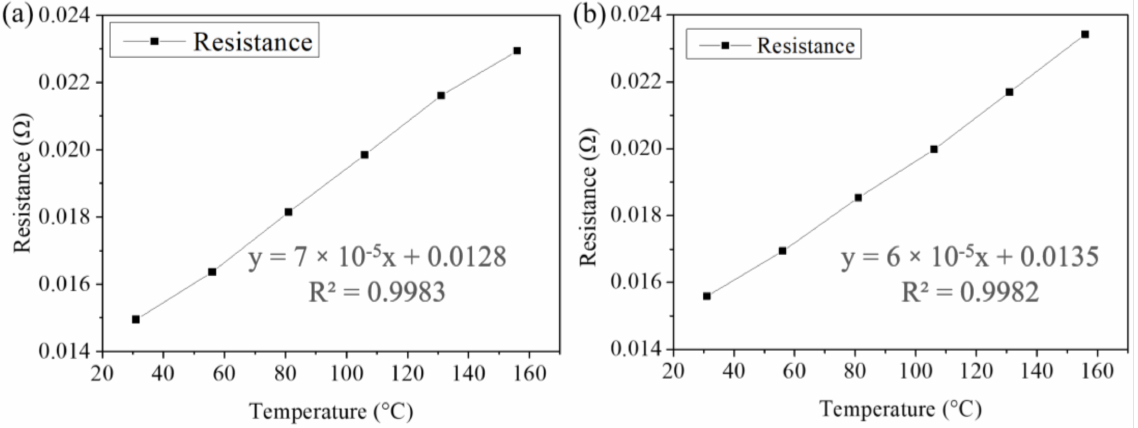
Figure 3. Relationship between hotplate temperature and resistance change during the TCR tests of ( a , b ) two solder joints using a Kelvin